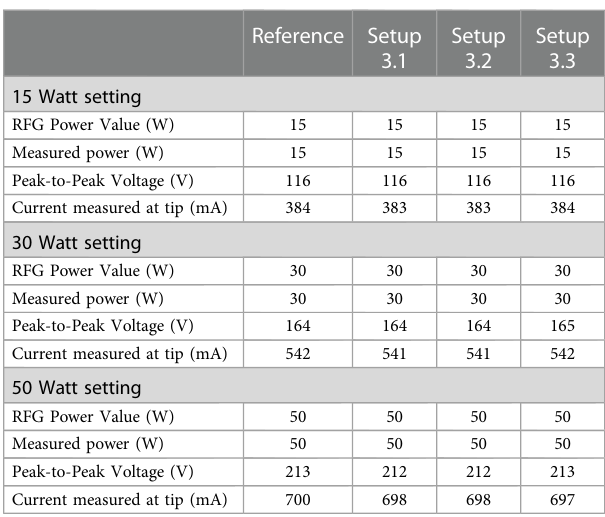
TABLE 1 Functional and safety parameters of DiamondTemp TM radiofrequency